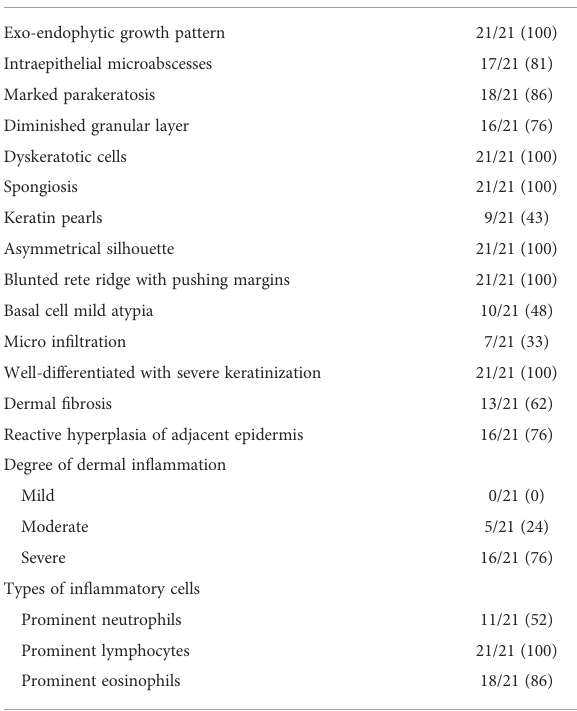
TABLE 2 Summary of pathologic